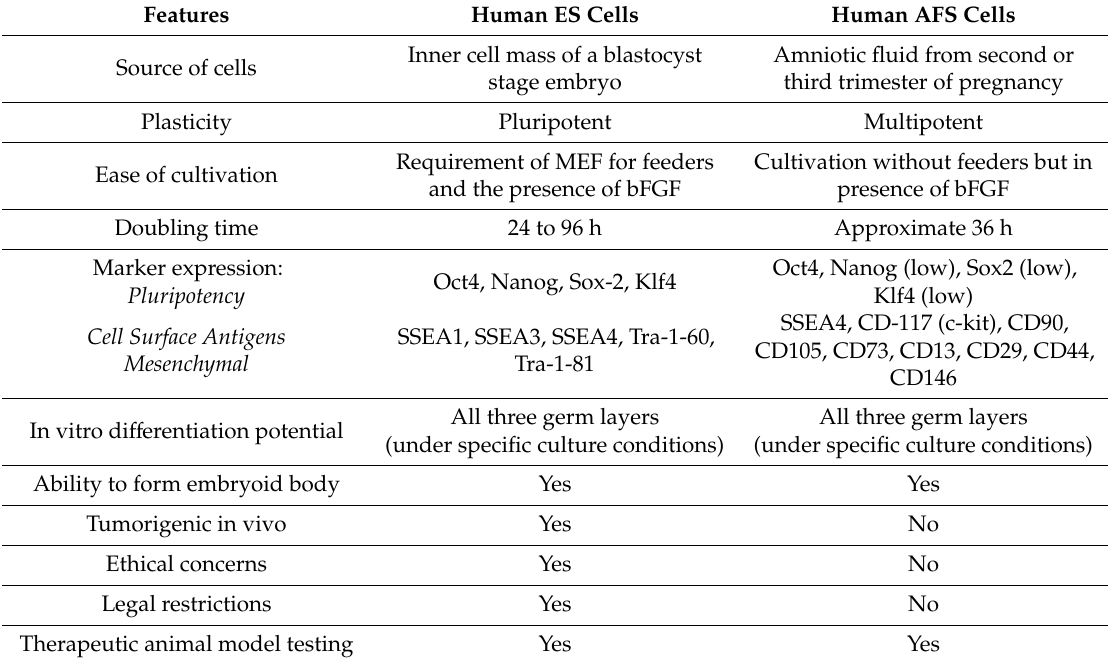
Table 1. Comparison between human embryonic stem (ES) cells and human amniotic fluid stem (AFS)